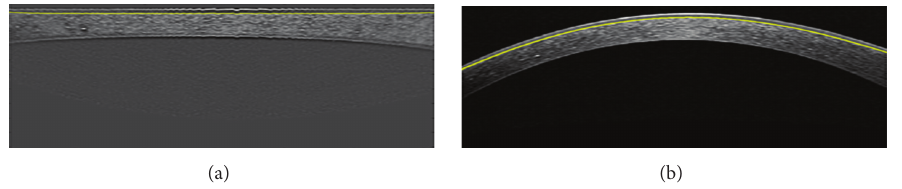
Figure 15: (a) Linear extrapolation of estimated Bowman boundary in the middle of the image. (b) Final result of Bowman boundary segmentation.